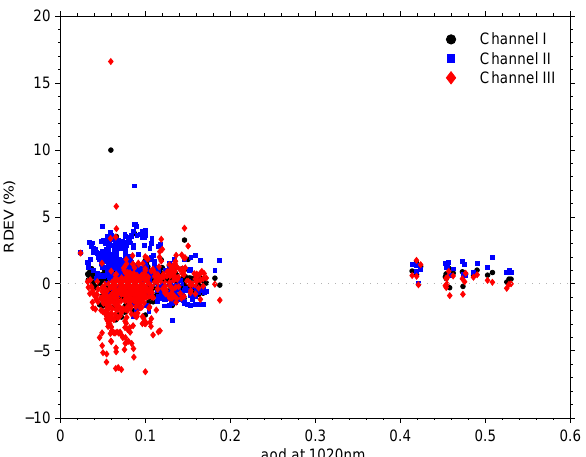
Fig. 6. Instantaneous relative deviation between Brewer and Mi- crotops II ozone against AOD 1020 . Only data for airmasses smaller than 3 are included.